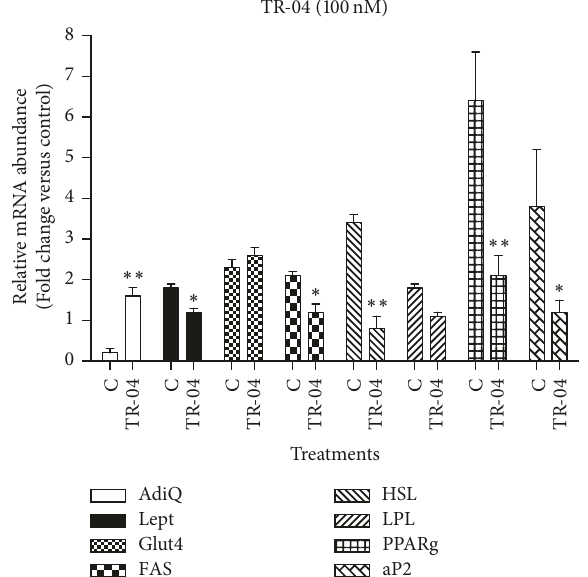
Figure 6: Effect of tetrahydrothiazolopyridine derivative TR-04 on the expression levels of adipocyte genes associated with lipid metabolismandinsulinresistance.Adipocytesweredifferentiatedin the presence of 1 𝜇 M cortisone and 100nM of TR-04 and extracted with TRIzol for mRNA measurements by qPCR. Data are the mean ± SEM ( 𝑛 = 3 ), normalized with respect to the expression of the 𝛽 -actin of undifferentiated control cells. ∗ 𝑝 < 0.05 and ∗∗ 𝑝 < 0.01 versus vehicle control by two-tailed Student’s 𝑡